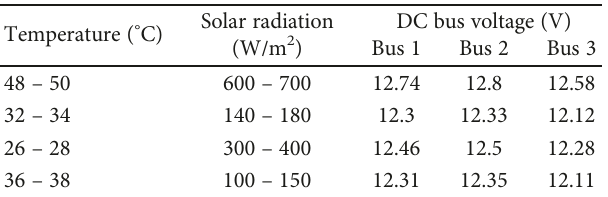
Table 1: DC distribution voltage of the proposed multiple-source con fi guration.